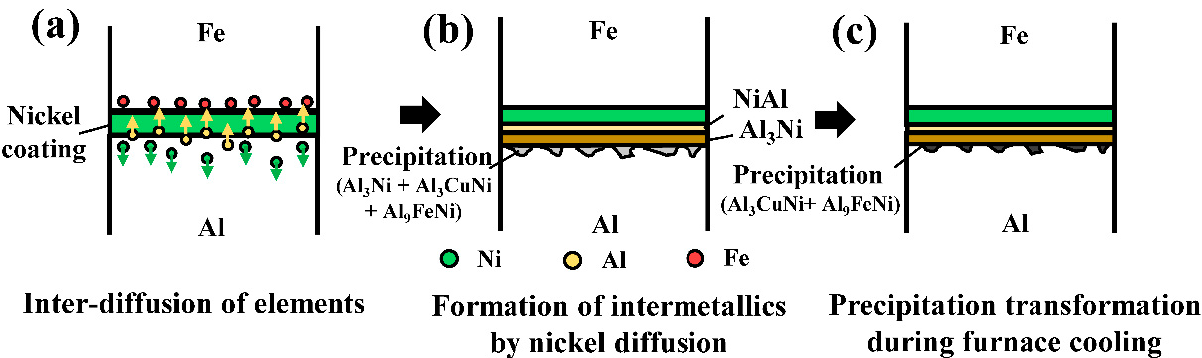
Figure 8. Schematic illustration of the chemical bonding process of the Al/Fe alloys hybrid structure under optimized heat treatment condition.